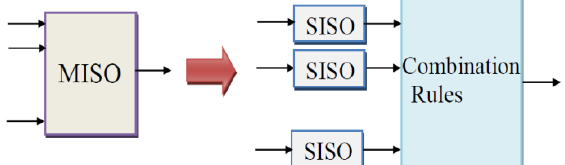
Figure 1. ALM breaks Multiple - Inputs - Single - Output (MISO) system into several Single - Input - Single - Output (SISO) subsystems and aggregates the behavior of subsystems to obtain the final output.